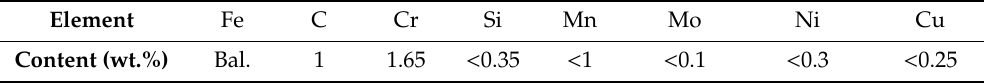
Table 3. Chemical composition of the GCR15 steel